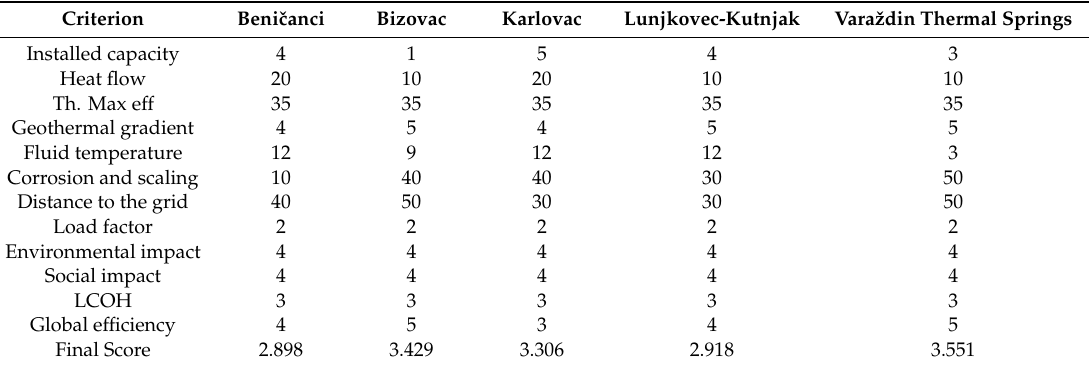
Table 7. Weighted scores for agricultural